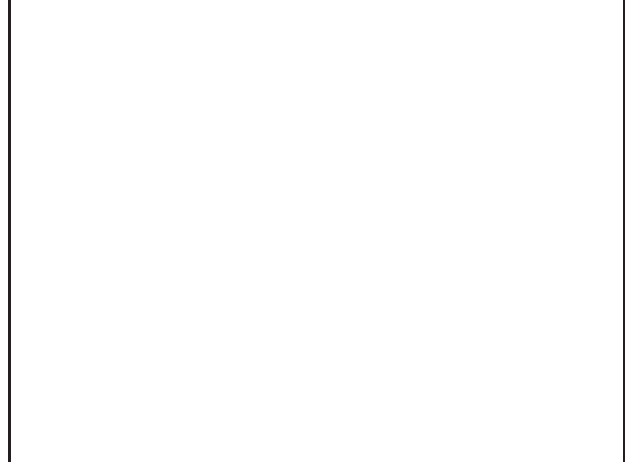
Fig. 7 : Normal Fundus of Right Eye (No DR changes even after 19 yrs duration of Diabetes